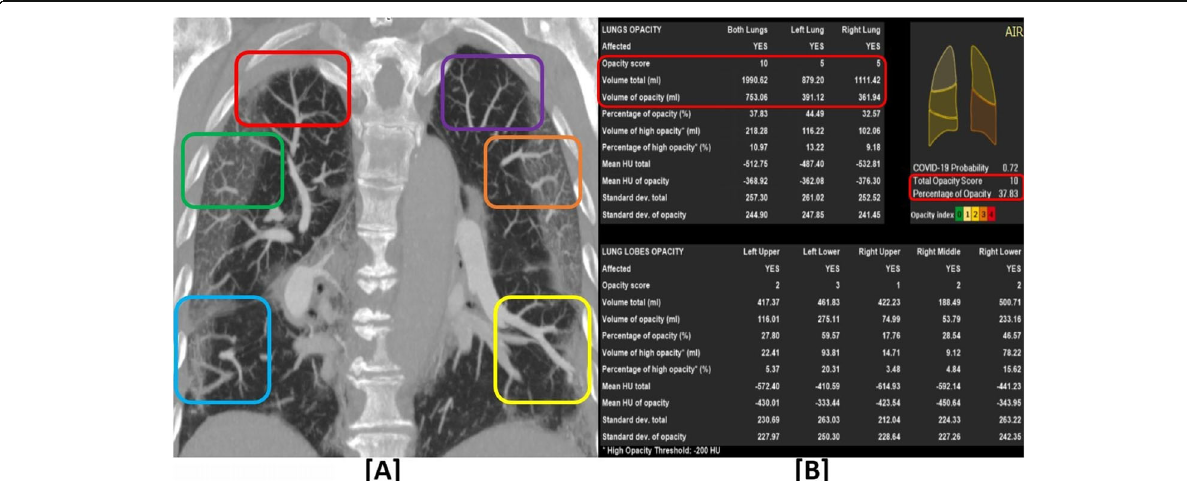
Fig. 4 A 72-year-old COVID-19 male patient with pulmonary vascular enlargement (PVE) on a background of borderline total opacity score (TOS): a Coronal lung window CTPA revealed bilateral basal pulmonary vascular dilatation (more on the left side with relatively increased opacity density) manifested by abnormally increased calibre within the pulmonary abnormal opacity as well as lack of tapering and extension till the pleural surface (blue and yellow squares). Bilateral upper lobar PVE is also noted within the pulmonary abnormal ground-glass opacity (more on the left side — brown square) compared to the nearby cranial vessels in (purple square) and contralateral same level vessels in (green square). Right apical PVE outside the abnormal opacity is also noted (red square). b Detailed artificial intelligence quantitative assessment revealed: TOS = 10/20 and volumetric percentage = 37.83%